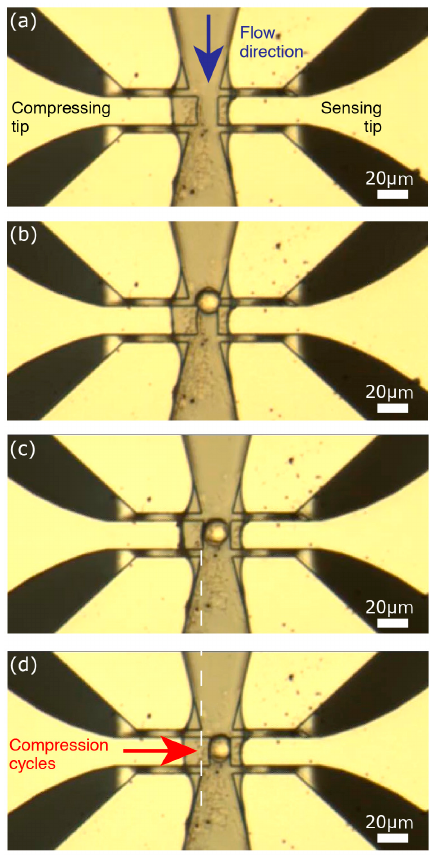
Figure 11. Sequential photos demonstrate single cell capturing. ( a ) Applying a potential difference between the compressing actuator electrodes narrows the gap between the tips; ( b ) The solution is kept flowing until a cell arrives at the handling area; ( c ) Then, the flow rate and the potential difference between the compressing actuator electrodes are decreased until the cell is positioned between the tips; ( d ) Finally, the flow is completely stopped and cell compression is performed.